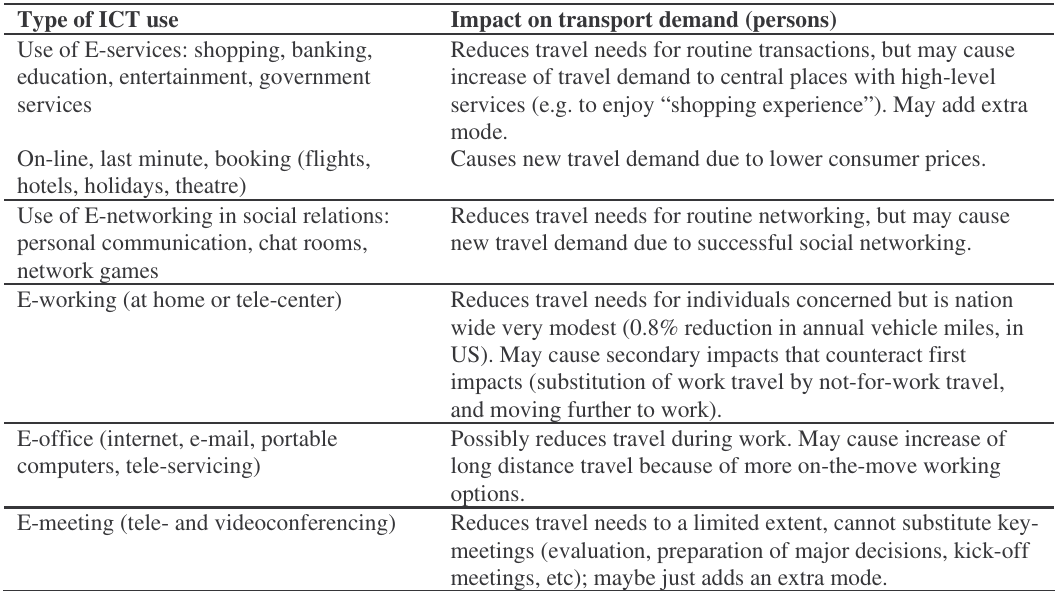
Table 2. ICT use by persons and transport demand Type of ICT